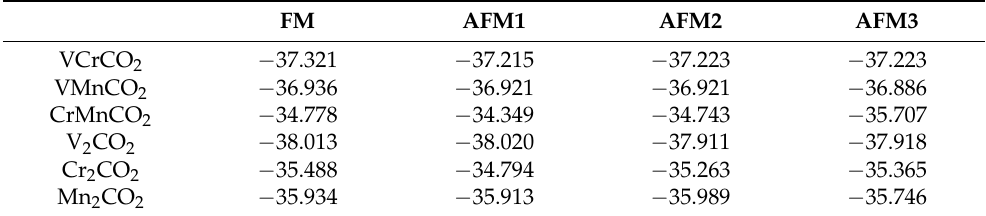
Table 3. The total energy of FM and AFM structures of M ’ MCO 2 , the unit of total energy is eV/u.c (unit cell).